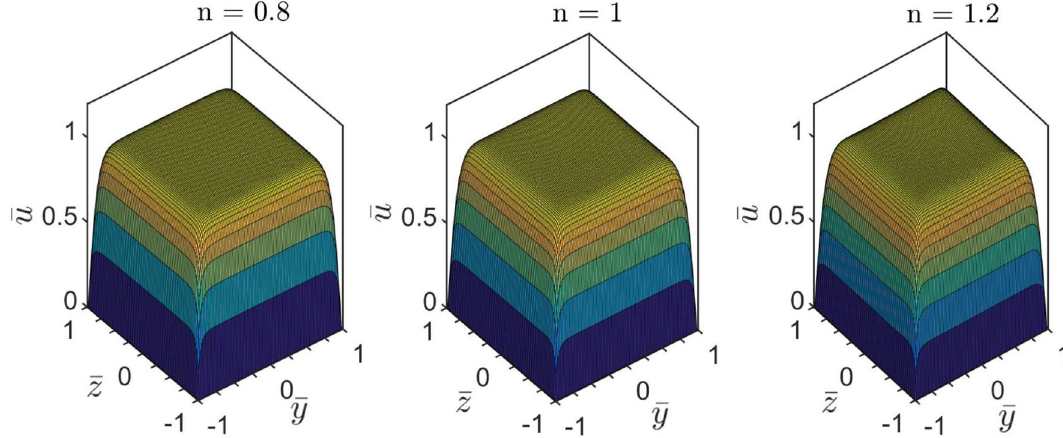
Figure 10. Plots depict three-dimensional velocity distribution for different values of n at κ = 20 , and Ŵ = 0 using Spreadsheet analysis